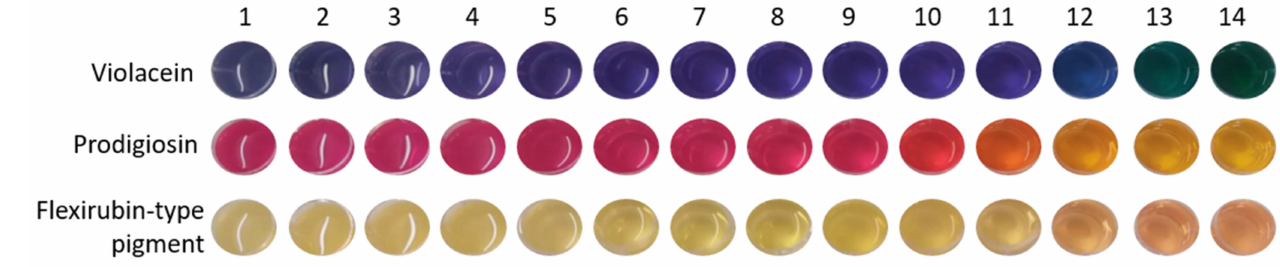
Figure 1. Color of violacein, prodigiosin and flexirubin-type pigment solutions at pH 1 to